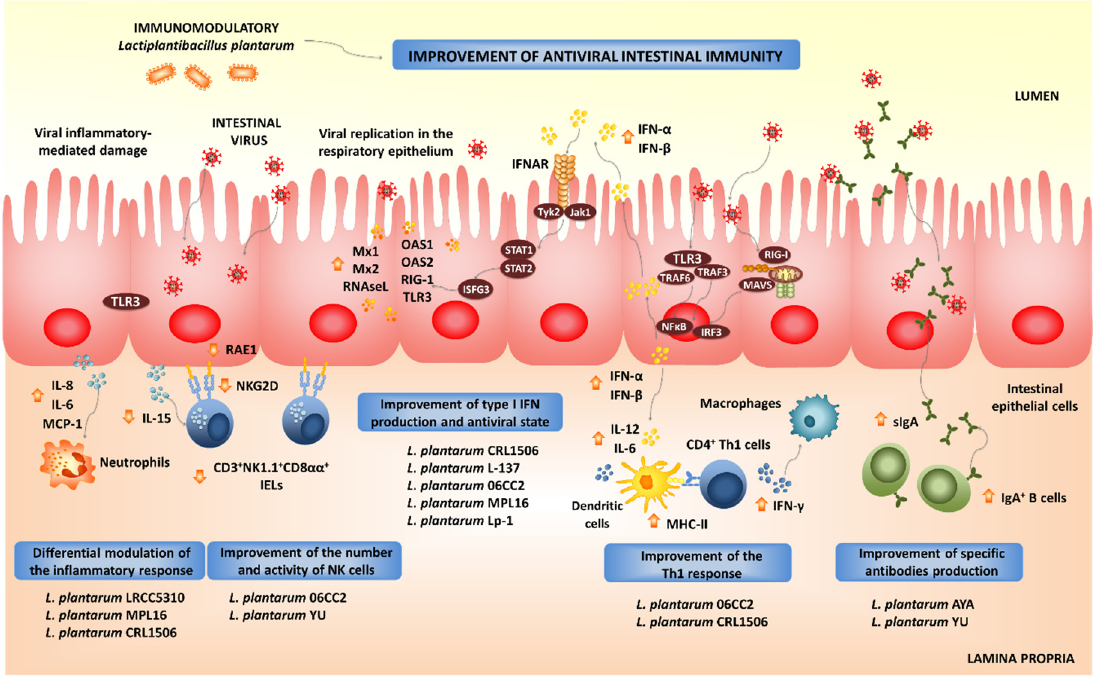
Figure 3. Beneficial effects of orally administered immunobiotic Lactiplantibacillus plantarum strains on the resistance and immune responses against virus in the intestinal mucosa.